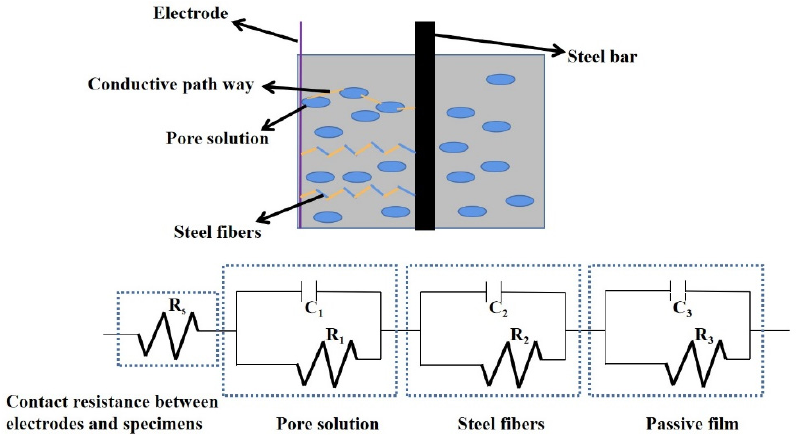
Figure 17. AC impedance spectrum curves.